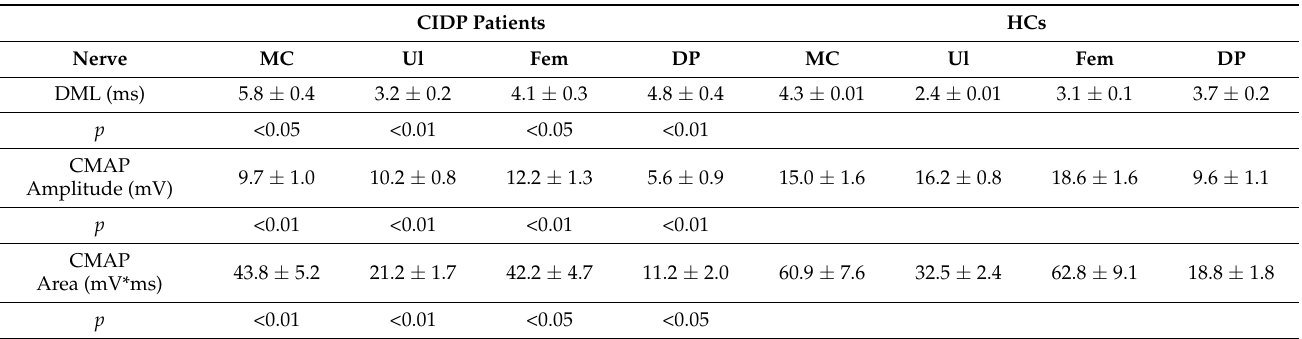
Table 3. Distal motor latency (DML) and CMAP amplitude and area of CIDP patients after ScIg treatment and HCs.